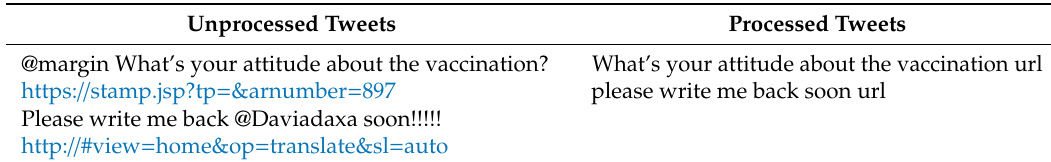
Table 2. The process of data